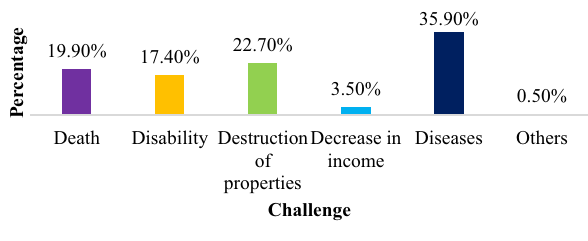
Fig. 5 Challenges of human ‒ wildlife